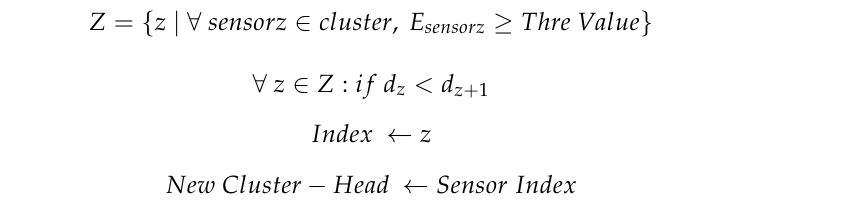
Table 8. Summary of network coverage-based cluster formation protocols.